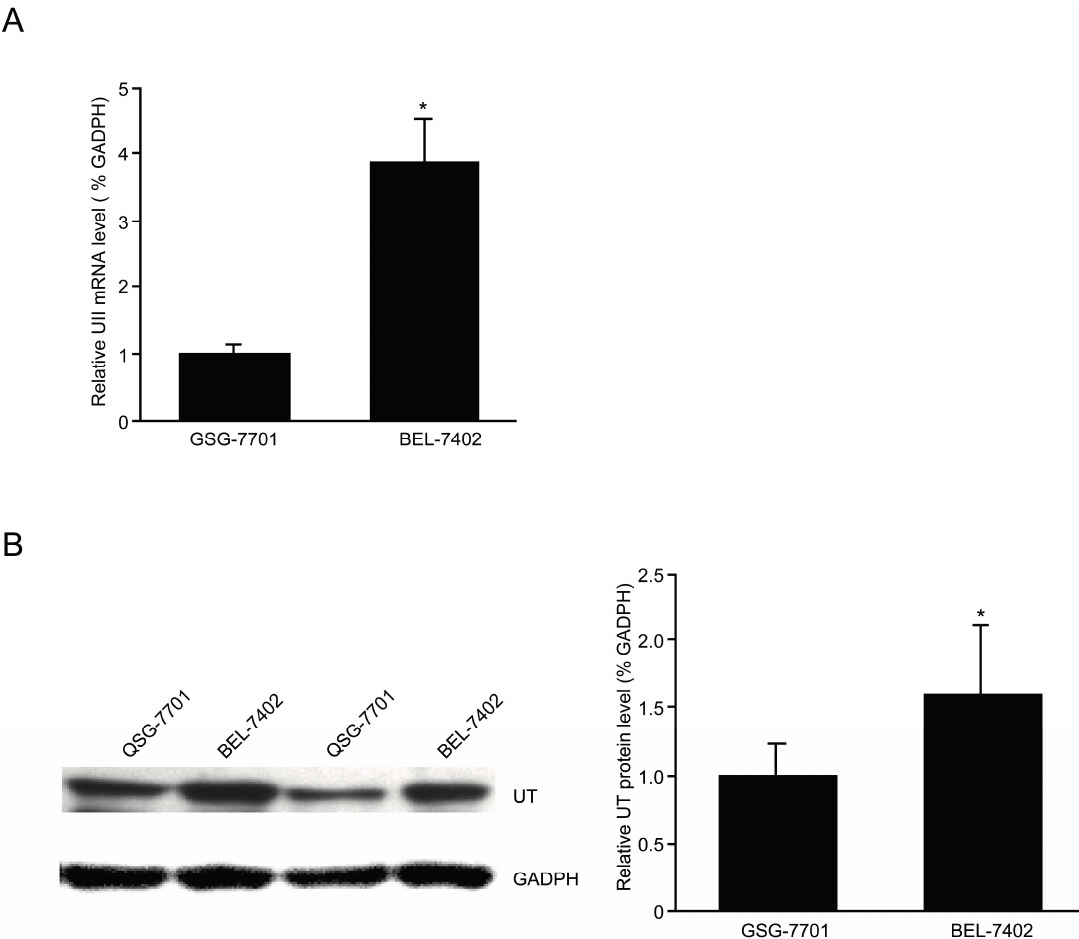
Figure 4. UII/UT system was up-regulated in BEL-7402 cells. ( A ) Expression of UII mRNA by qPCR; ( B ) Expression of UT protein by western blot analysis. Data are mean ± SE ( * p < 0.05 compared with